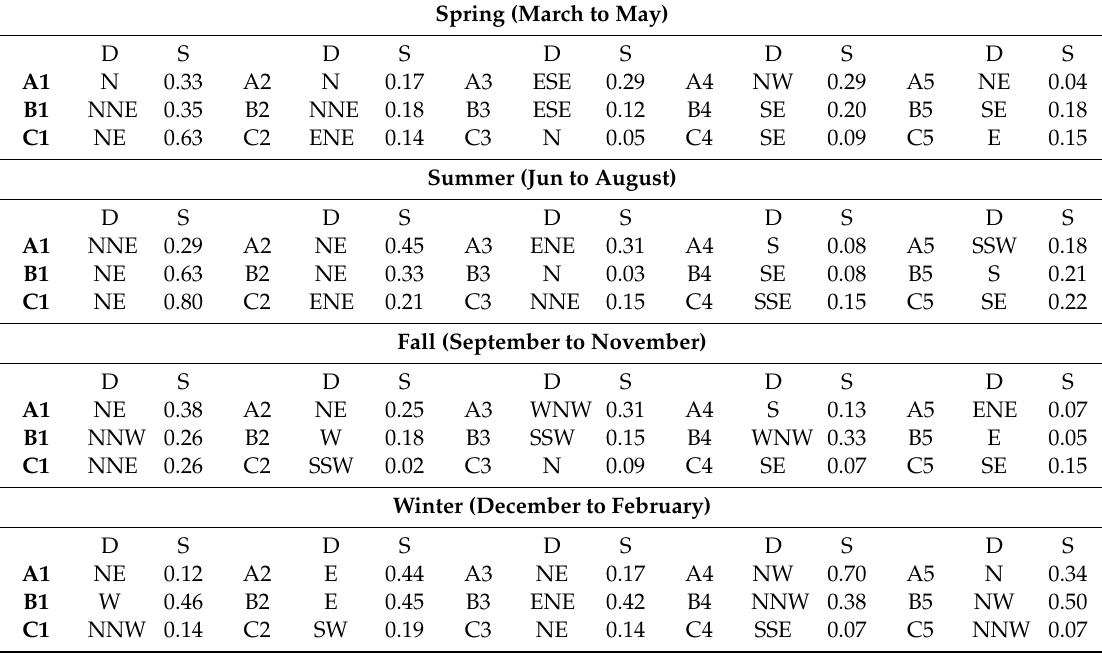
Table A1. Seasonal flow field data from Sb-ADCP data (Figure 3). S represents the flow speed (m / s) and D represents the flow direction (sixteen bearings).